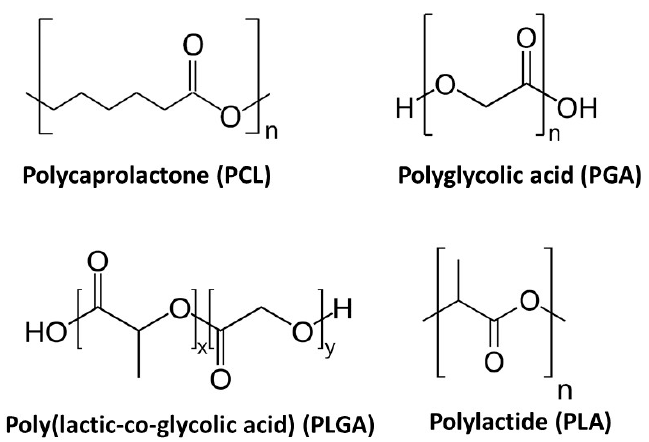
Figure 11. Chemical structure of the most commonly used synthetic polymers for the fabrication of electrospun TE scaffolds.